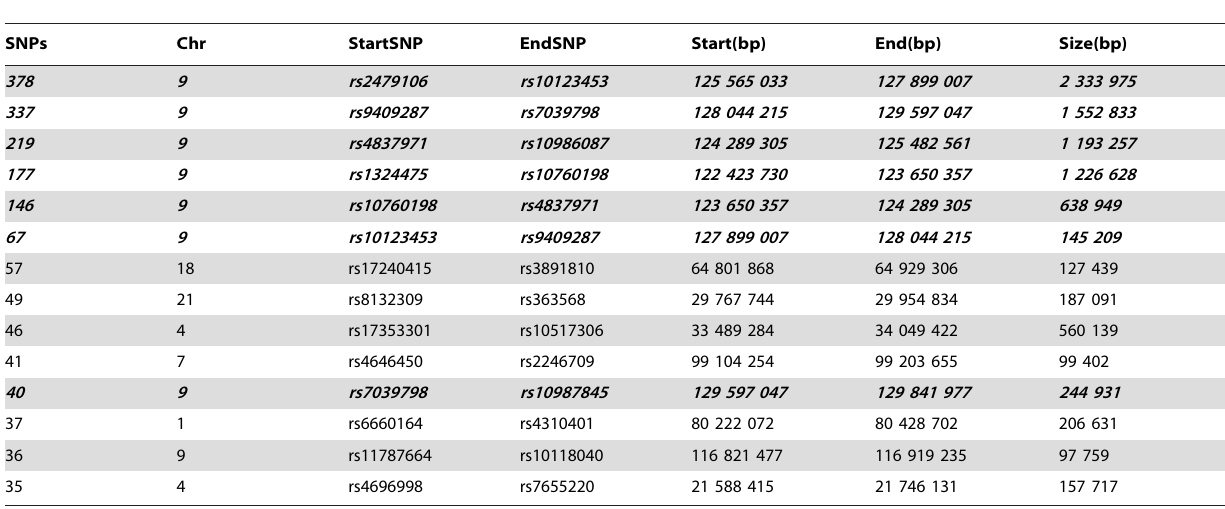
Table 1. All intervals of 35 or more consecutive SNPs homozygous and identical by state among the six affected CMT